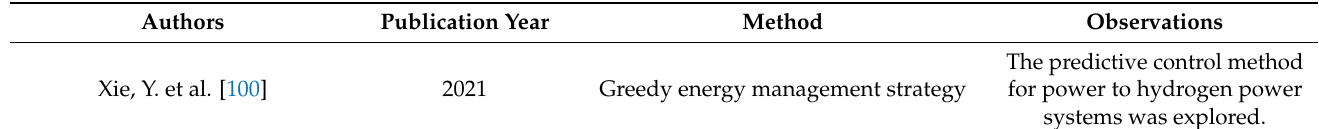
Table 3. Comparison of various energy management system